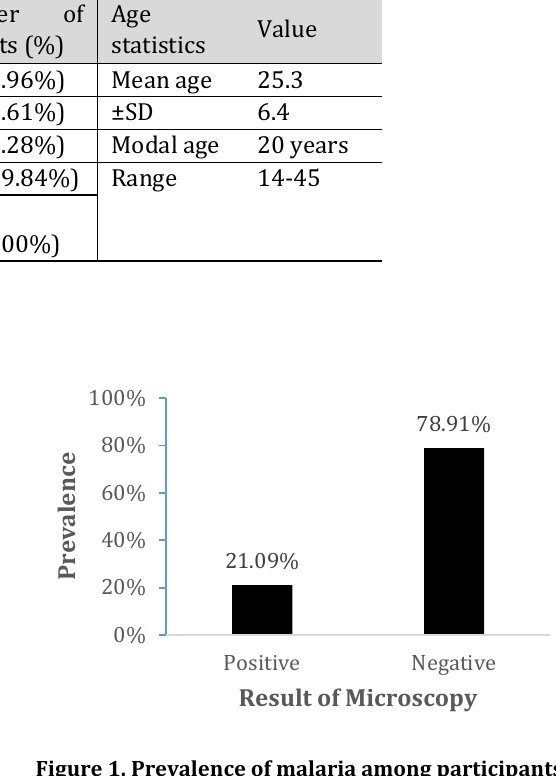
Figure 1. Prevalence of malaria among